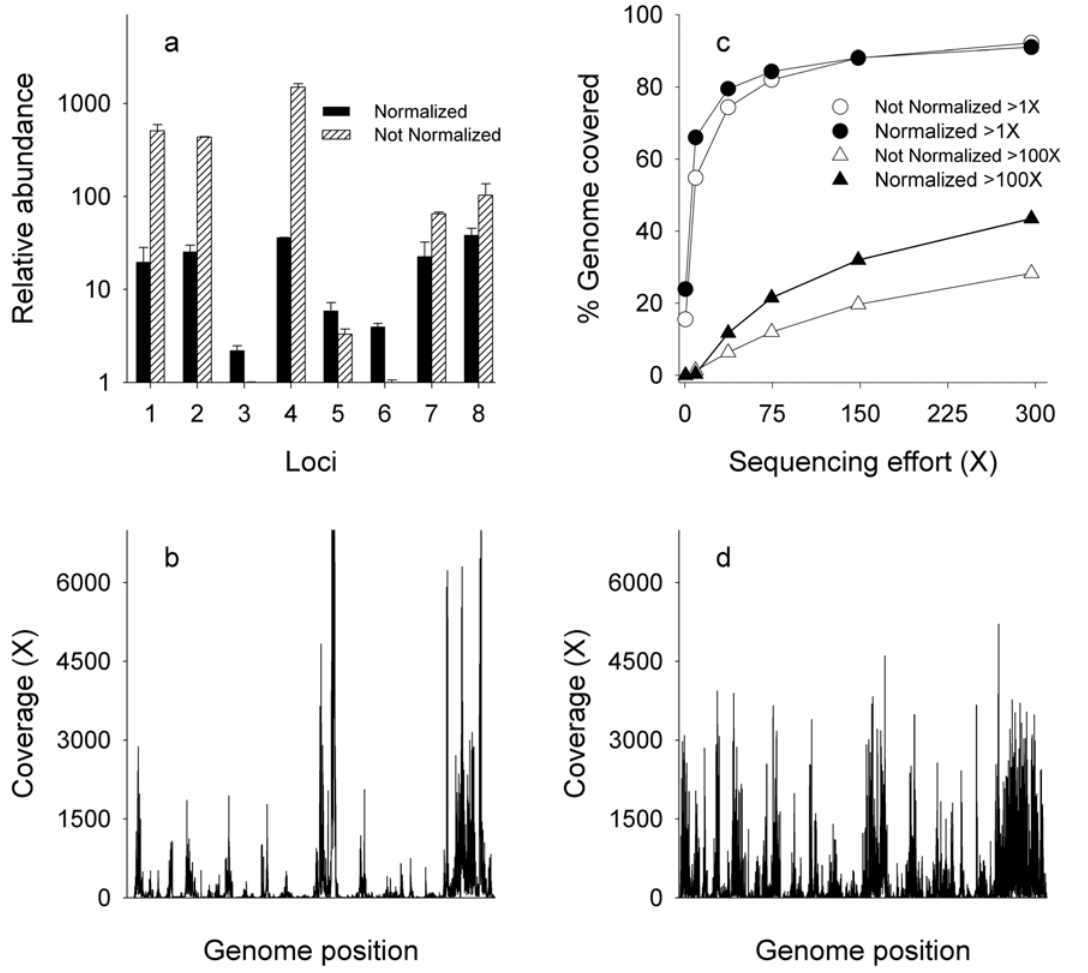
Figure 3. Impact of library normalization on coverage variation. A) The relative abundance of 8 loci distributed across the entire genome of SAG A before and after normalization. Error bars represent one standard deviation of three separate normalization reactions. B) Coverage depth of SAG A prior to normalization. C) Fraction of genome covered at . 1X and . 100X in normalized and non-normalized control libraries of SAG A. Error bars representing 95% confidence intervals are obscured by symbols. D) Coverage depth of SAG A after